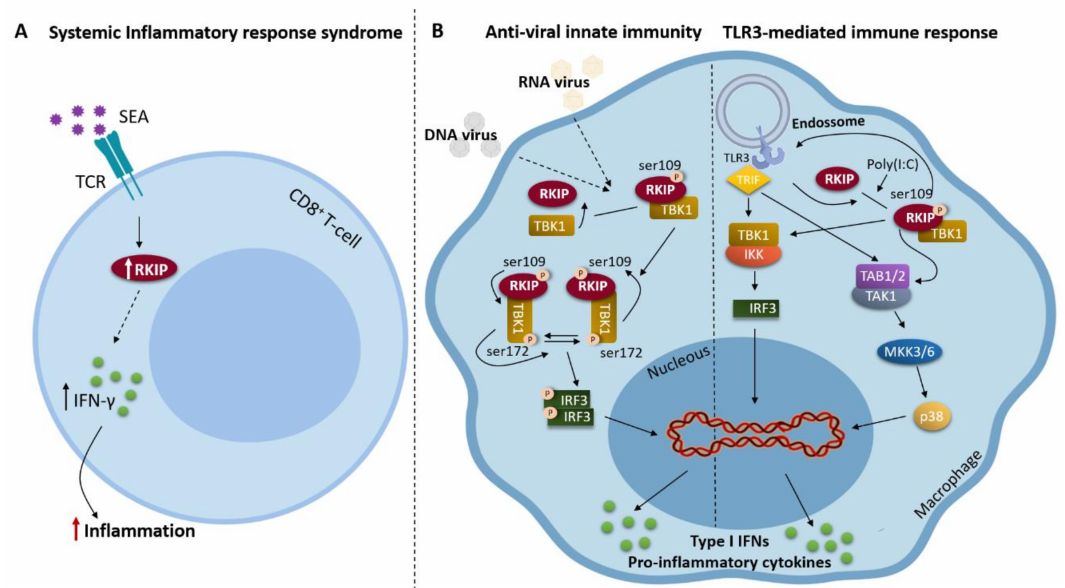
Figure 2. Role of RKIP in interferons and pro-inflammatory cytokines production during inflammatory processes. ( A ) RKIP enhances the production of interferon- γ after triggering of the T cell receptor (TCR) with staphylococcal enterotoxin A (SEA) in CD8 + systemic inflammatory response syndrome (SIRS) T cells. ( B ) On the left side, upon viral infection, TBK1 phosphorylates RKIP at S109 in macrophages. The phosphorylation of RKIP enhances its interaction with TBK1 and in turn promotes TBK1 autophosphorylation at S172, thus triggering a positive feedback control of TBK1 activation, which